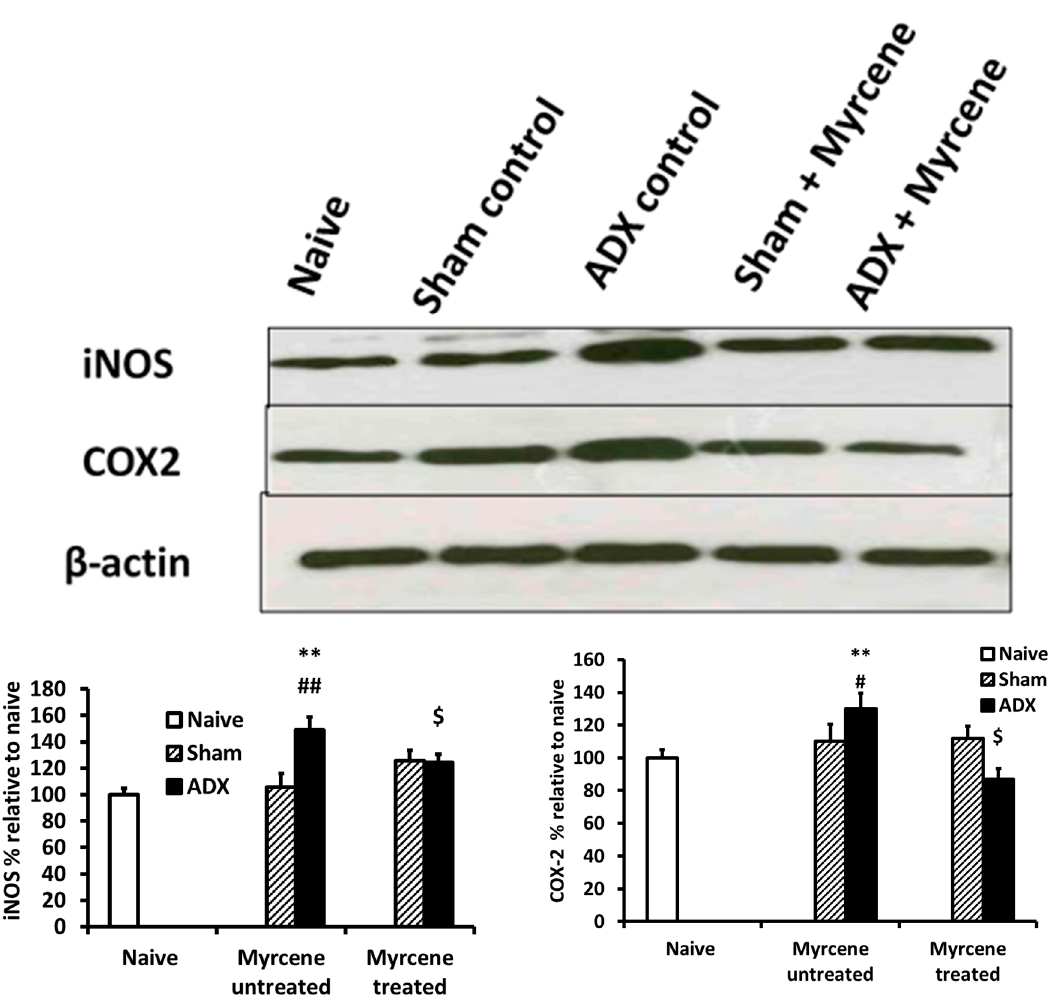
Figure 6. Quantification of iNOS and COX-2 in kidney tissue of ADX, naïve, sham operated, and myrcene treated ADX and sham rats measured by western blotting. A significant increase in iNOS and COX-2 was observed in the untreated ADX group rats compared to the naïve and sham operated control. Myrcene treatment significantly decreased the expression of iNOS and COX-2. Values are expressed as the mean ± STD ( n = 3). ** p < 0.01 compared to naïve; # p < 0.05, ## p < 0.01 compared to untreated sham; $ p < 0.05 compared to untreated